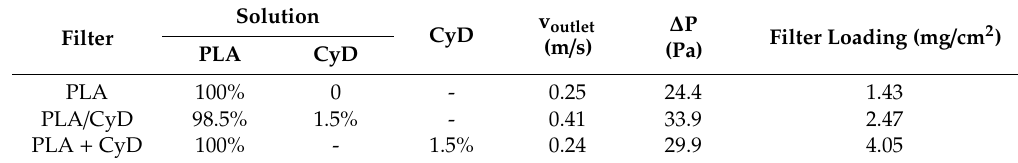
Table 1. Composition and characterization of the electrospun filter media.